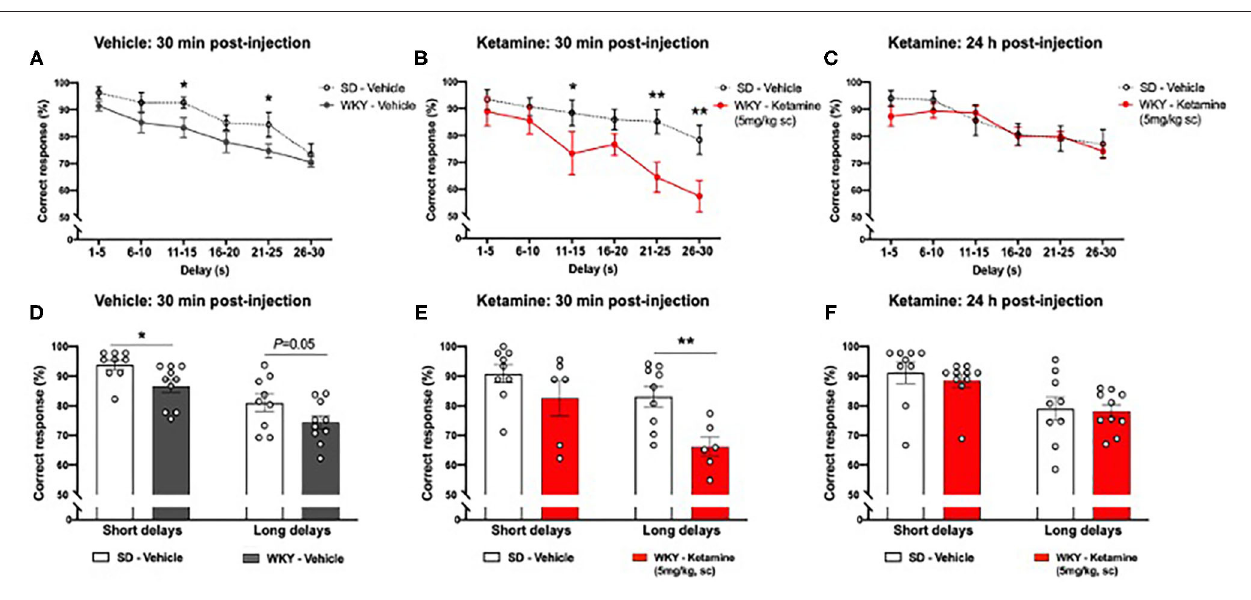
FIGURE 5 | WKY showed impaired performance in the DNMP task in comparison to SD rats, single administration of ketamine further impaired performance 30min post-administration but improved performance 24h post-administration (A) WKY and SD performance in the DNMP 30min after vehicle administration. (B) WKY 30min post-administration of ketamine (5 mg/kg s.c.) and SD vehicle 30min post-administration of vehicle. (C) WKY 24h post-administration of ketamine (5 mg/kg, s.c.) and SD vehicle 24h post-administration of vehicle. (D) WKY and SD performance 30min after vehicle administration, correct responses grouped by short (1–15s) and long (16–30s) delay periods. (E) WKY 30min post-administration of ketamine (5 mg/kg, s.c.) and SD vehicle 30min post-administration of vehicle, correct responses grouped by short (1–15s) and long (16–30s) delay periods. (F) WKY 24h post-administration of ketamine (5 mg/kg, s.c.) and SD vehicle